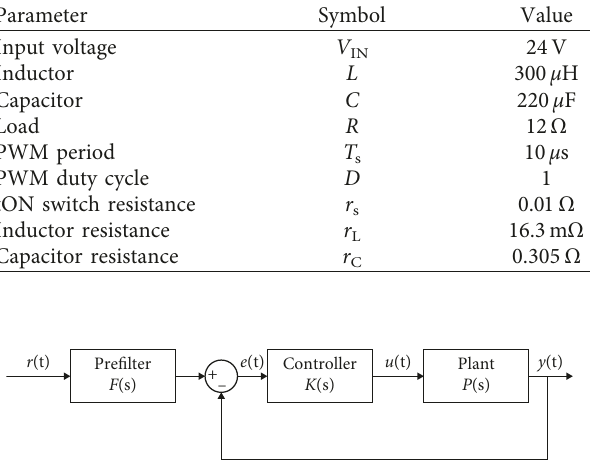
Figure 2: 2-Degree-of-freedom QFT control